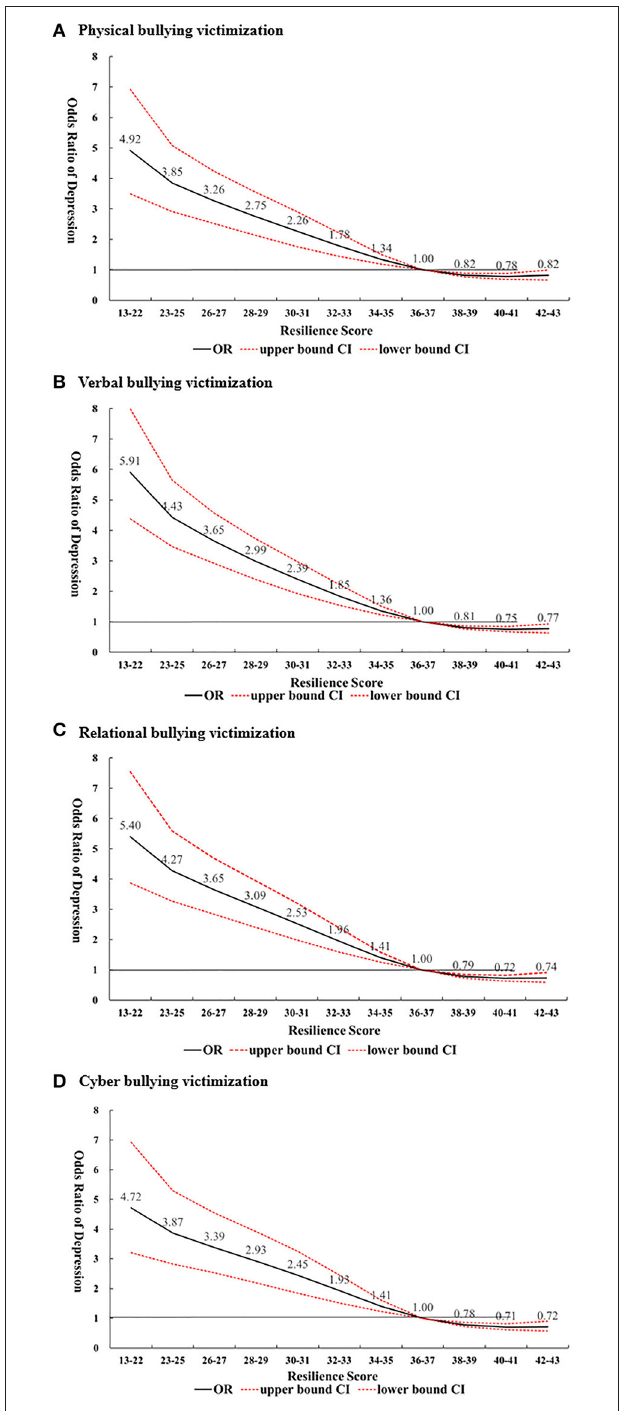
FIGURE 2 | Odds ratio of depression stratified by resilience score and type of bullying victimization. (A) Physical bullying victimization. (B) Verbal bullying victimization. (C) Relational bullying victimization. (D) Cyber bullying Victimization. The odds ratios were calculated by the Restrict Cubit Spline (RCS) Regression model, adjusted by gender, age, peer support, family support, mother’s ethnicity, mother’s education, father’s employment status, and household structure. Reference group was defined at the 50 th percentile resilience level, which included all the resilience scores from 36 to